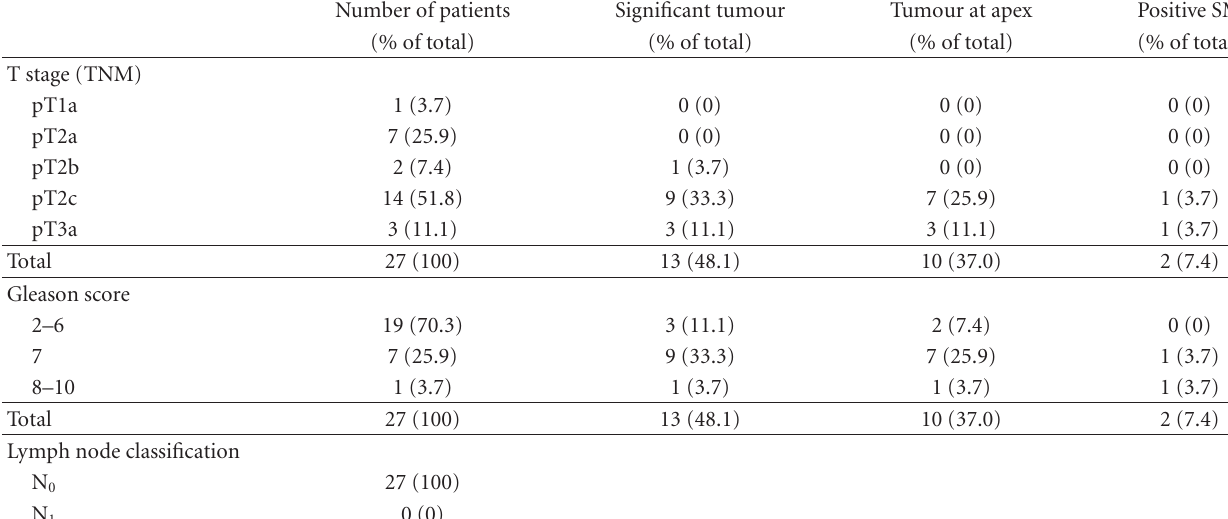
Table 1: The histological characteristics of the 27 prostate cancers identified in the 81 RCP specimens.